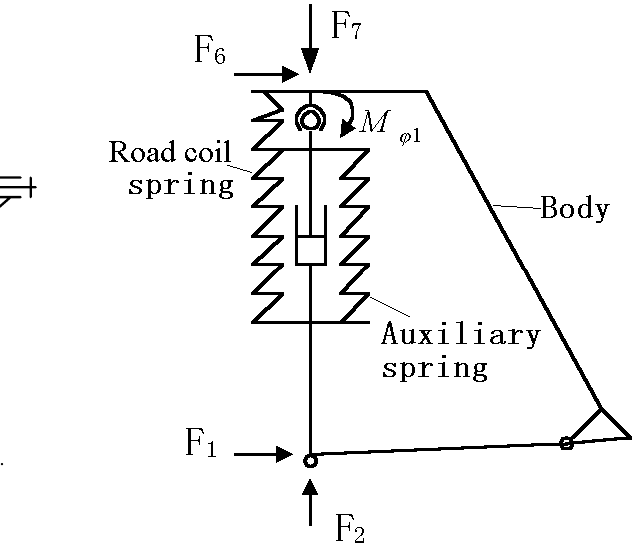
Fig. 3. Dynamic model of the rear suspension in the wheel plane.